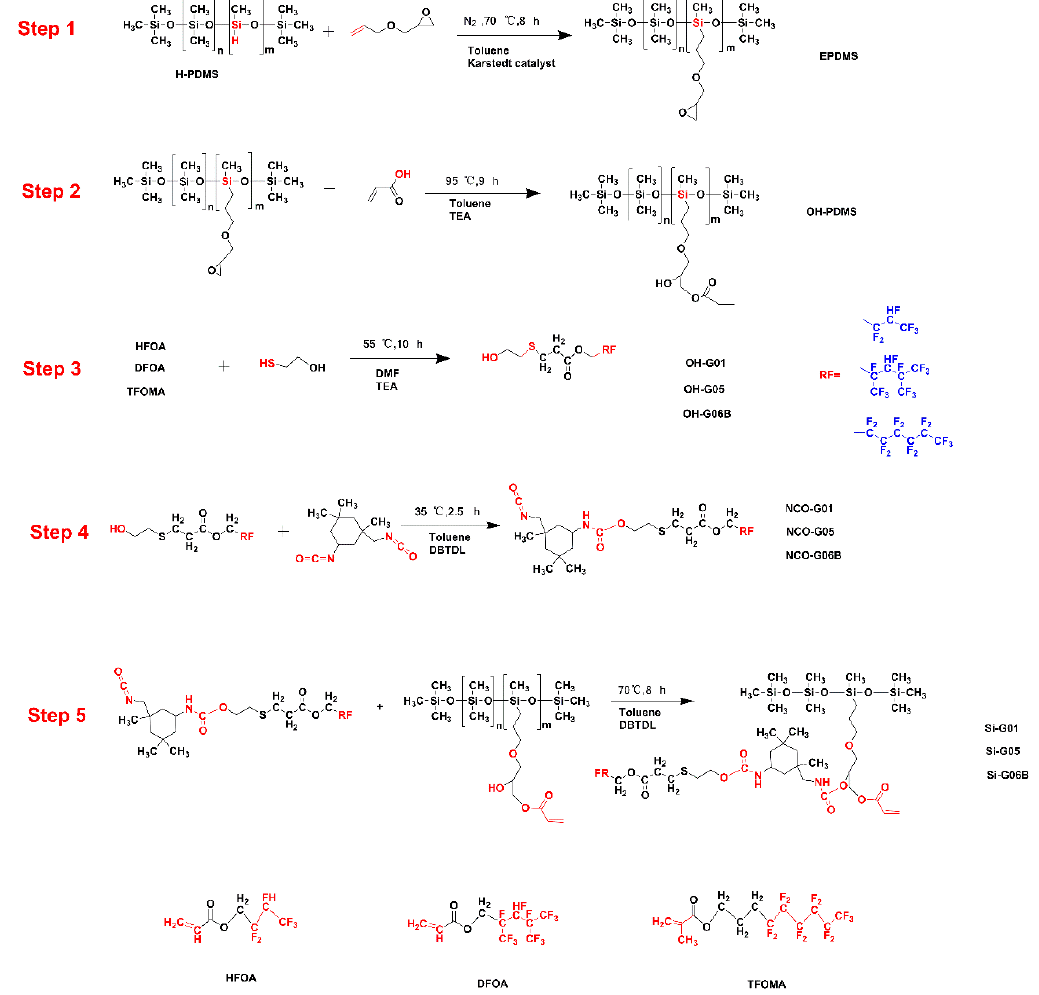
Figure 1. Synthesis of novel ultraviolet (UV)-curable fluorinated siloxane resins.